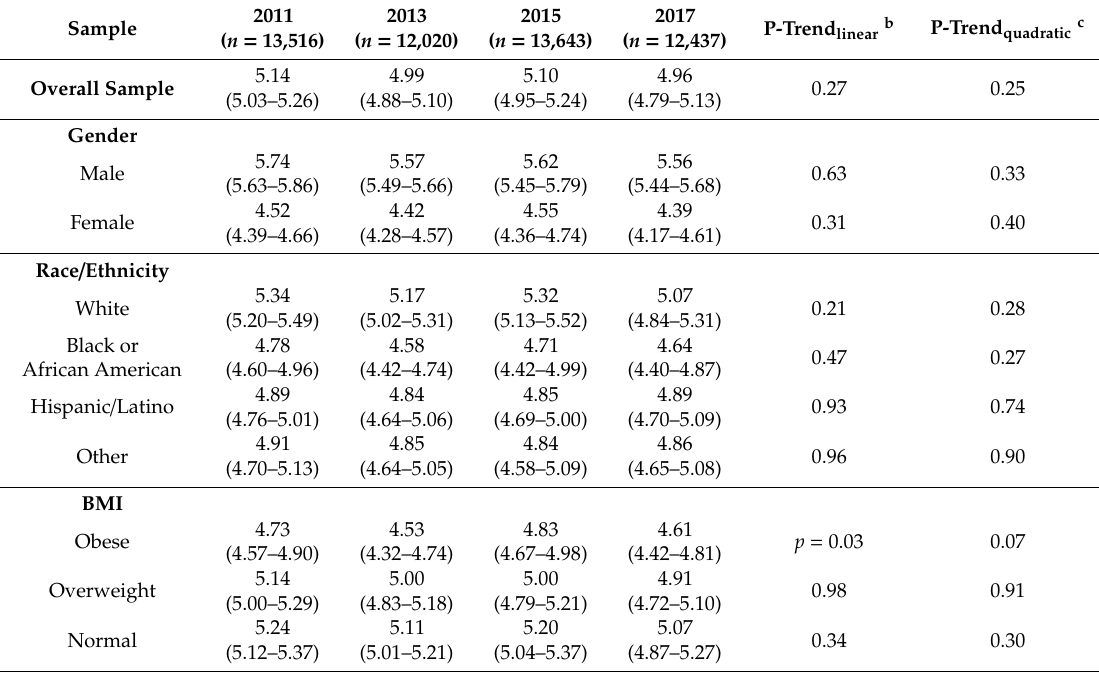
Table 3. Weighted mean number of days per week youth engaged in at least 60 m/d of physical activity (2011 – 2017 YRBSS; N = 51,616) a .